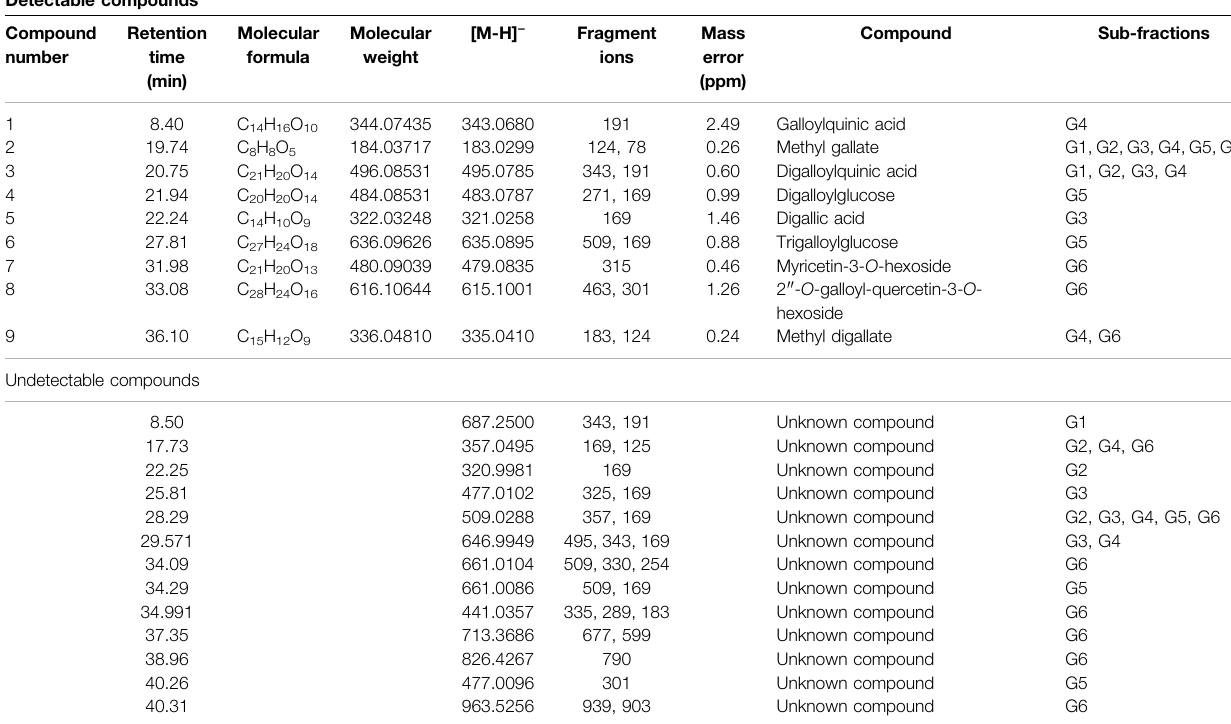
TABLE 7 | LC-QTOF-MS characterisation of compounds in G coded sub-fractions. Detectable compounds Compound